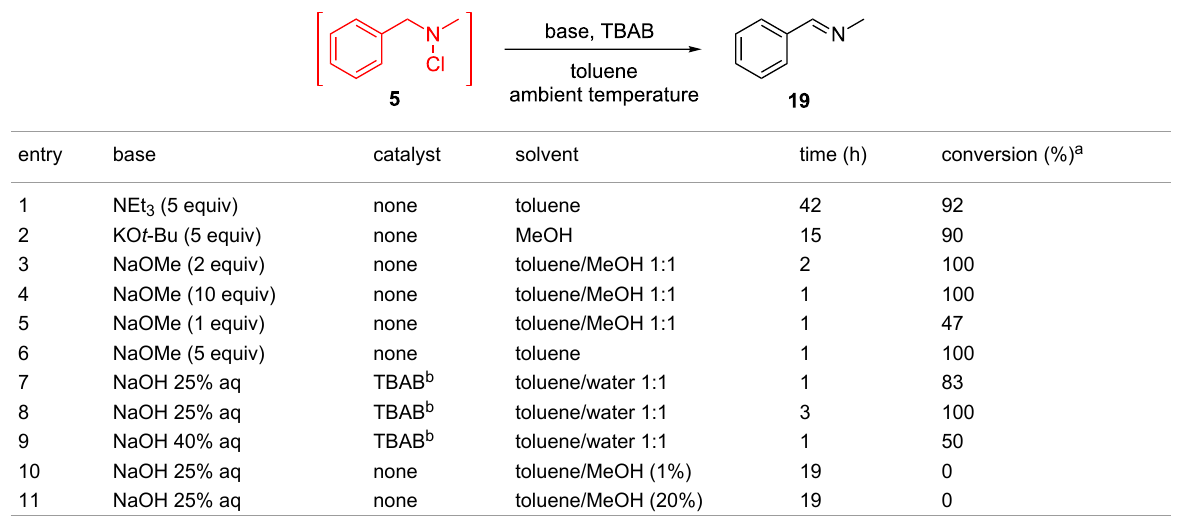
Table 4: Batch optimization study of the dehydrochlorination of N -chloramines.